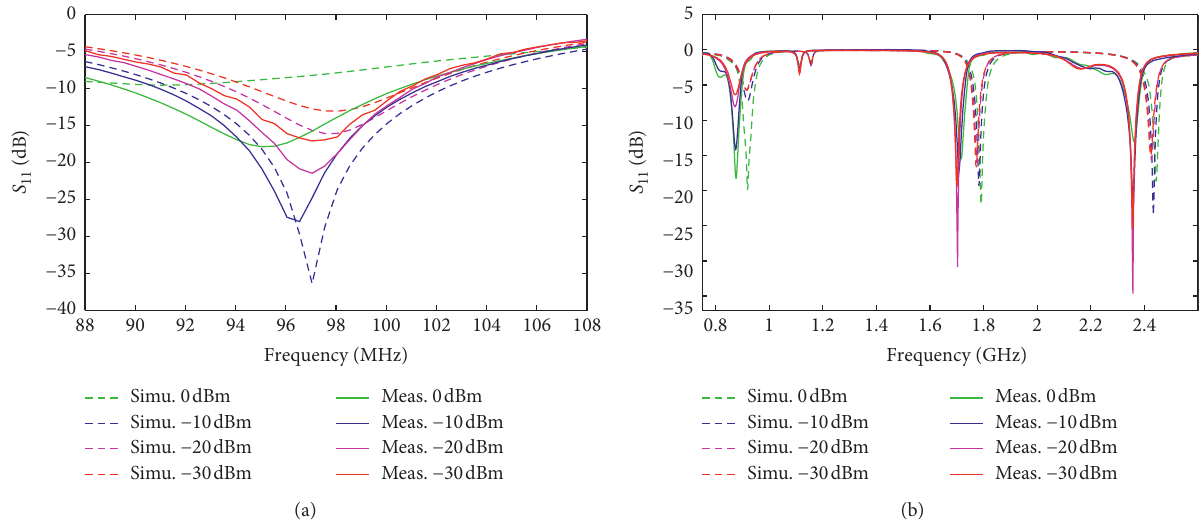
Figure 30: Simulated and measured S of the integrated multiband rectifier for 10k Ω load. (a) FM band. (b) 11